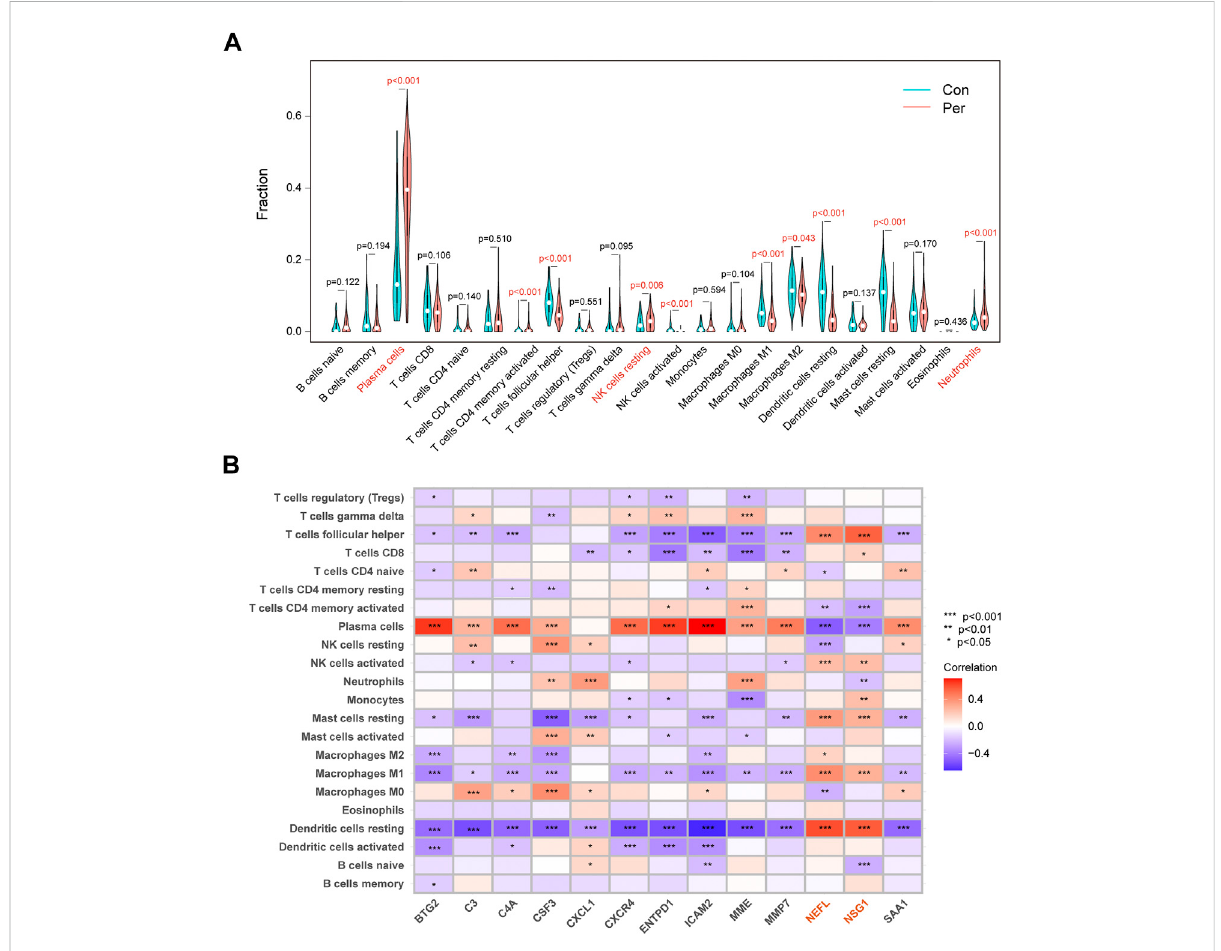
FIGURE 6 Immune in fi ltration differences and correlations. (A) Violin plots of the 22 immunocytes differences between control and periodontitis groups. (B) Correlation matrix of 13 key biomarkers and immunocytes distribution. * p < 0.05, ** p < 0.01, *** p <